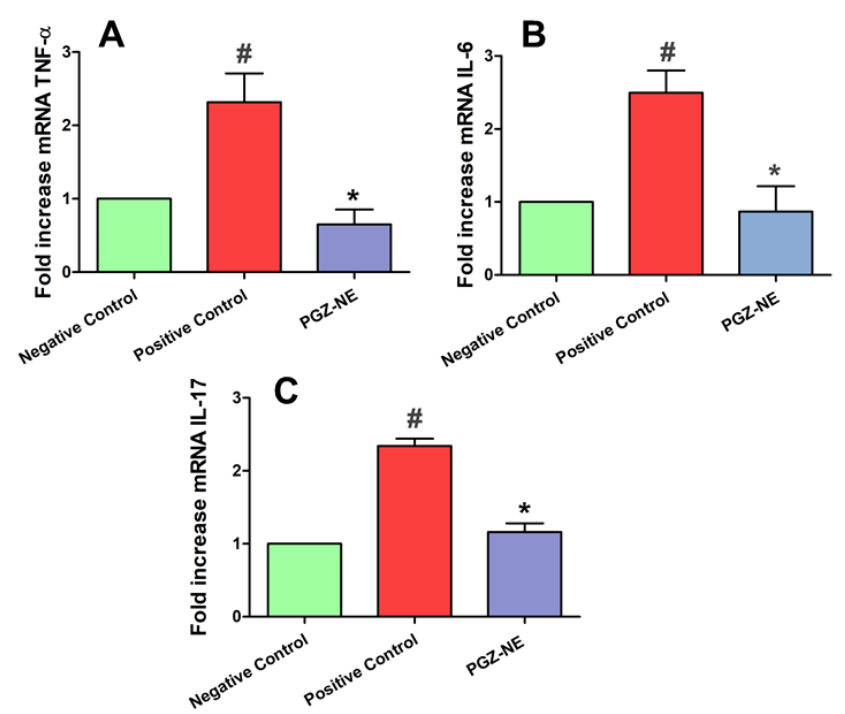
Figure 7. Relative expression of pro-inflammatory cytokines measured by quantitative reverse transcription polymerase chain reaction (RT-qPCR): ( A ) Tumor necrosis factor-alpha (TNF- α ); ( B ) Interleukin-6 (IL-6); and ( C ) Interleukin-17 (IL-17). Negative control (healthy mice), positive control (mice with oxazolone-induced atopic dermatitis) and PGZ-NE group (mice with oxazolone-induced atopic dermatitis treated with PGZ-NE). # p < 0.05 negative control vs. positive control. * p < 0.05 positive control vs. PGZ-NE treatment.